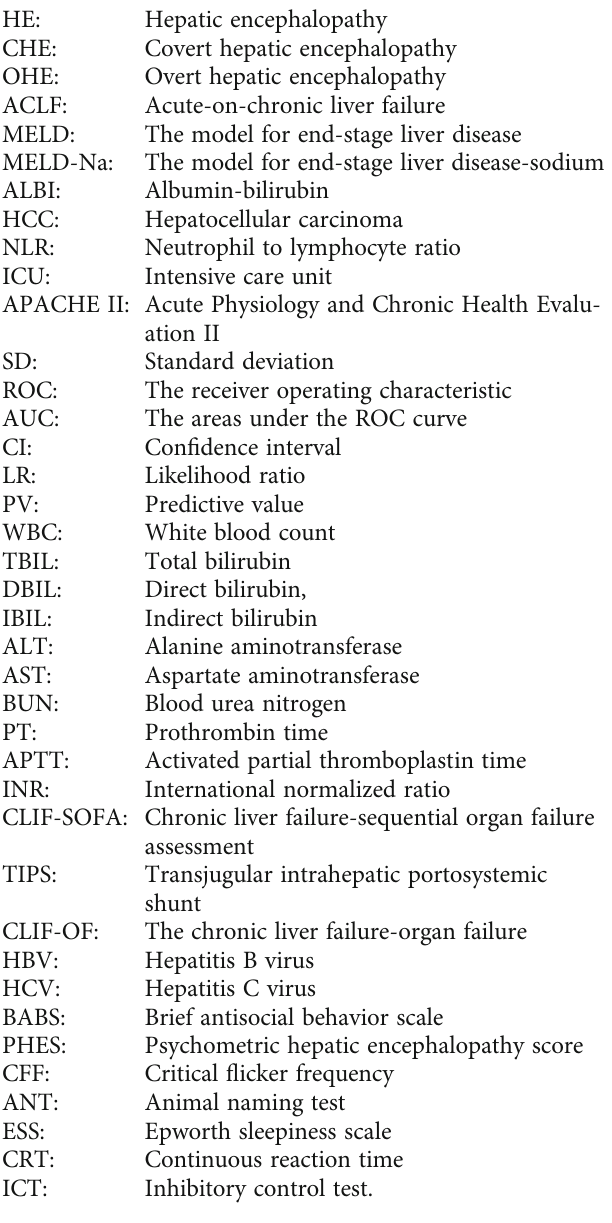
Supplementary 1 . Table S1 Logistic rfegression analysis of risk factors for in-hospital death. Supplementary 2 . Table S2 Logistic regression analysis of risk factors for hepatic encephalopathy severity. Supplementary 3 . Table S3 Logistic regression analysis of risk factors for acute-on-chronic liver